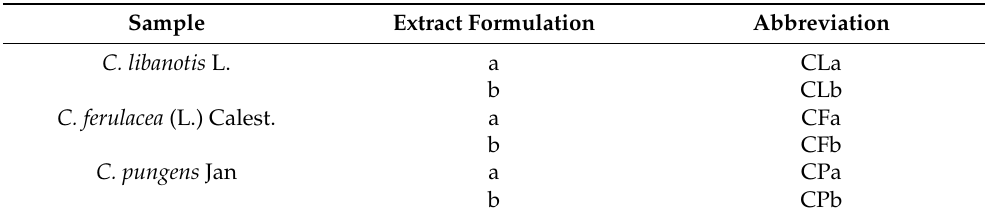
Table 3. Investigated Cachrys species and extract formulations “a” and “b”, prepared as reported in the Materials and Methods Section